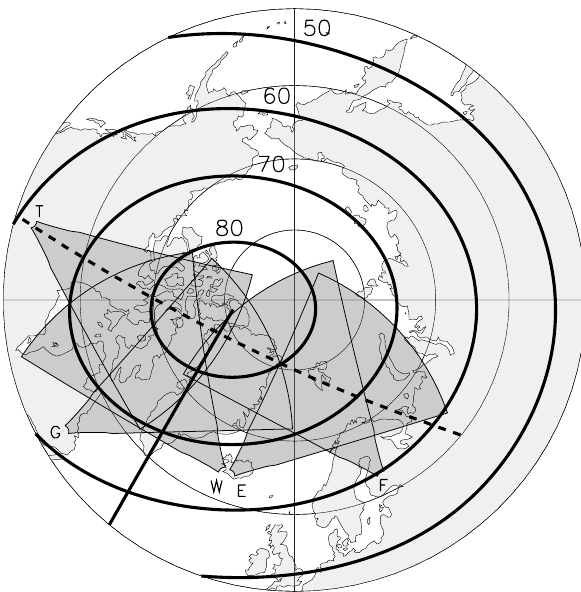
Fig. 1. Geographic map showing the fields-of-view of the five Su- perDARN radars used in the study. Geomagnetic latitudes from 50 to 80 ◦ latitude are shown with bold lines, the faint lines show ge- ographic latitude over the same latitude range. The transit of the DMSP F13 satellite between 13:24 and 13:38 UT is shown by the dashed line. The bold magnetic meridian line (bottom left quadrant of the figure) marks magnetic noon at 13:30